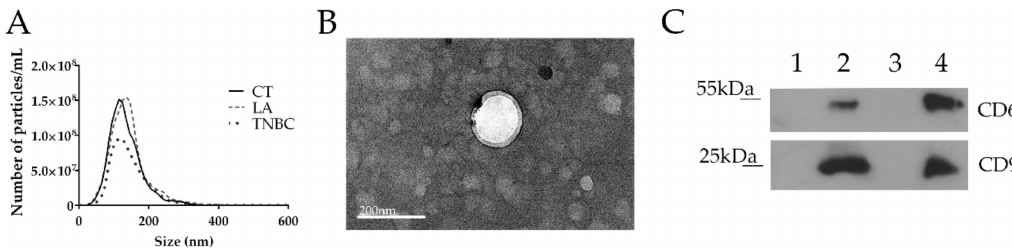
Figure 2. Extracellular vescile (EV) characterization. ( A ) Nanoparticle tracking analysis (NTA) showing a peak between 100–200 nm for the control (CT), luminal A (LA), and triple negative (TNBC) groups. ( B ) Transmission electron microscopy (TEM) image of EVs from cancer patient showing a size corresponding to NTA results. Size bar = 200 nm. ( C ) Western blotting (WB) analysis showing strong protein expression of CD9 and CD63 on EVs from control (2) and cancer (4), when compared with corresponding serum supernatant EV-depleted from control (1) and cancer